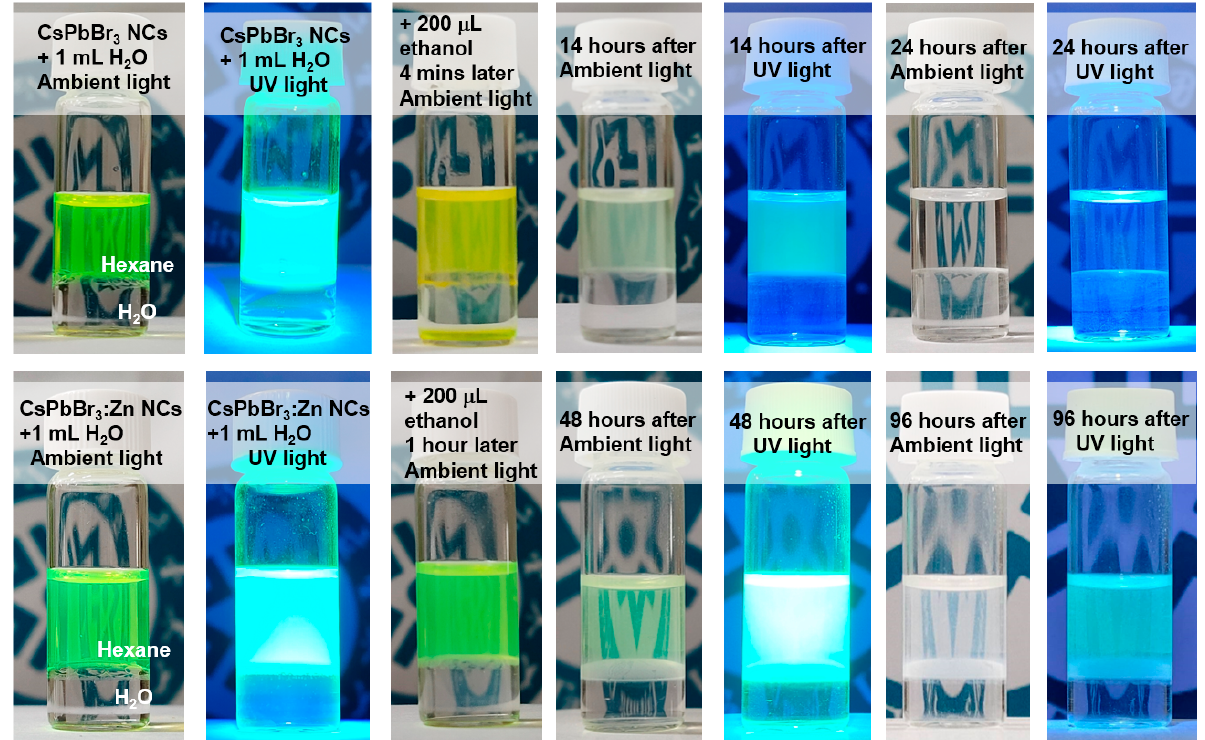
Figure 5. Photographs of variation of NC solutions with and without the ethanol addition under ambient light and UV light, respectively.